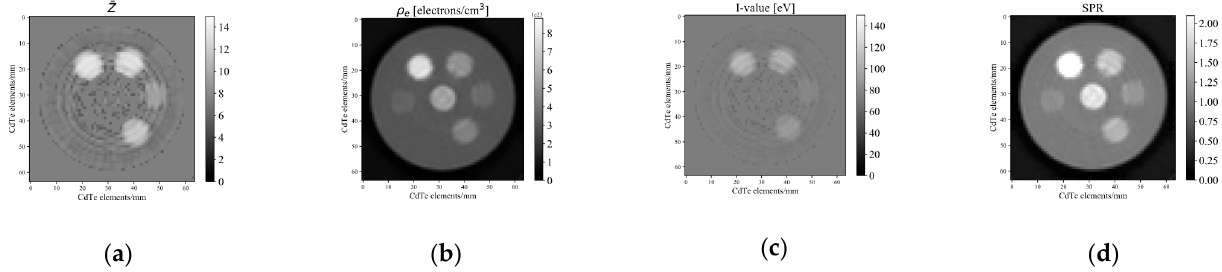
Figure 9. Maps calculated via two-PFM for ( a ) effective atomic number, ( b ) electron density, ( c ) I -value, and ( d ) SPR. The I -values were parameterised using the fitting curve of the mixture in Figure 4, calculated using the Bragg additivity rule.